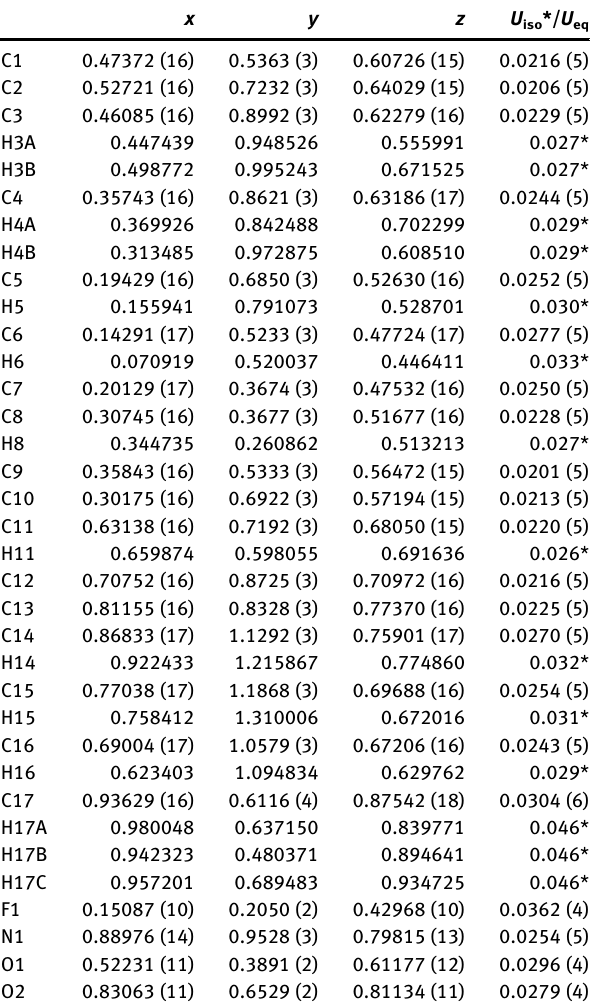
Table  : Fractional atomic coordinates and isotropic or equivalent isotropic displacement parameters (Å 